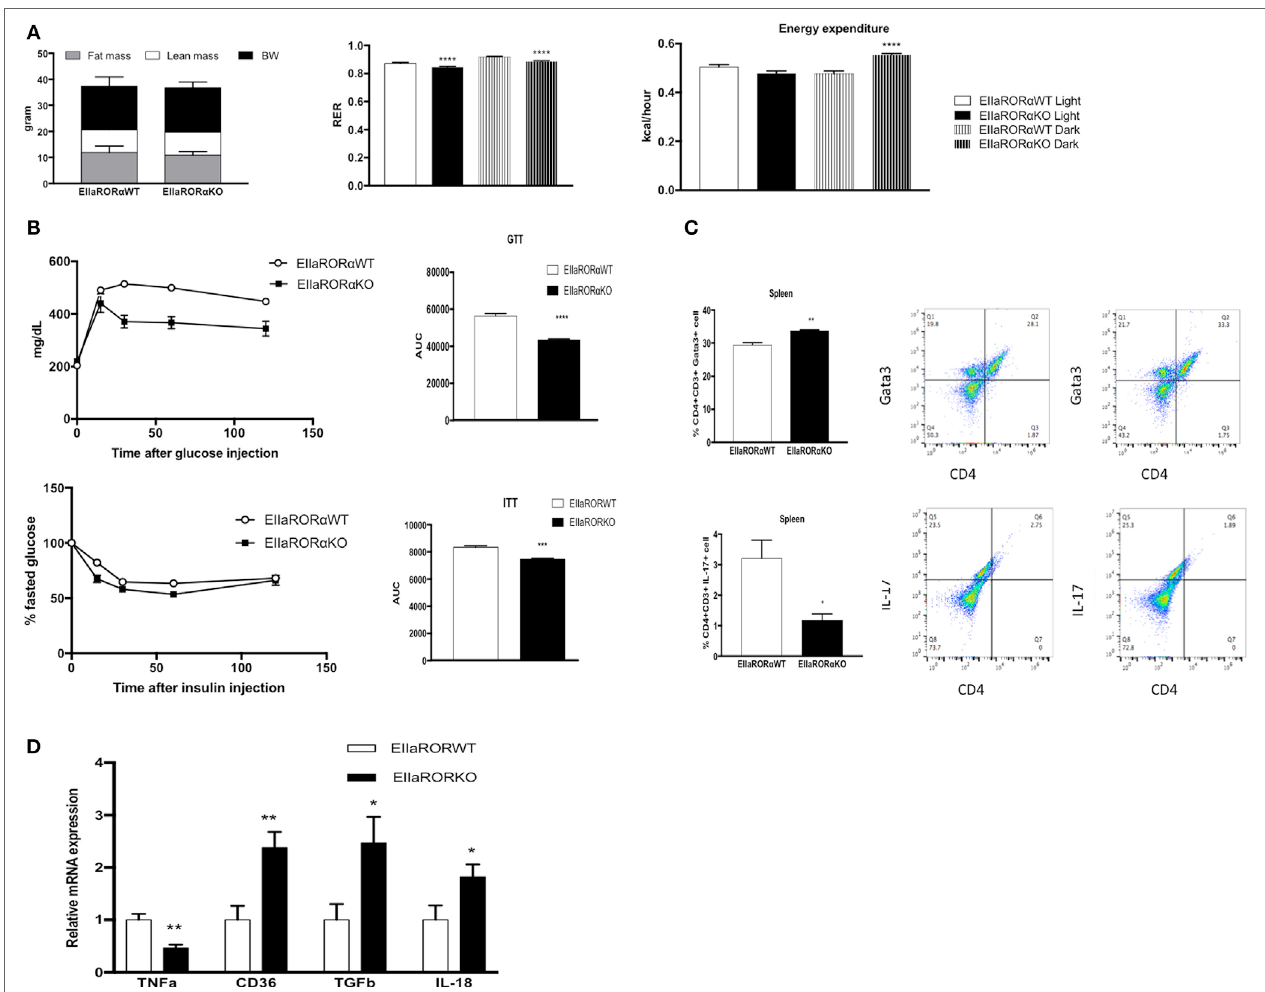
FigUre 5 | Aged-EIIAROR α KO display improved glucose homeostasis and a lower inflammation rate than EIIAROR α WT mice. (a) Body composition of single-housed 15-month-old males EIIAROR α WT ( n = 6) and EIIAROR α KO ( n = 7) littermates (left panel) fed with a normal chow diet. Respiration exchange ratio (middle panel) and heat production (right panel) of the same aged-EIIAROR α WT (white, n = 6) and EIIAROR α KO (black, n = 7) littermates during day (solid pattern) or night (shaded pattern) over a 5-day period and after 24 h acclimation (upper panel). (B) Glucose (upper panel) and insulin (lower panel) tolerance test from the same males aged-EIIAROR α WT (white triangle, n = 6) and EIIAROR α KO (black square, n = 7) fed with a normal chow diet done at 13-month old. Area under the curve is represented on each graph. (c) Splenocytes from 15-month-old males EIIAROR α WT (white bar, n = 6) and EIIAROR α KO (black bar, n = 7) littermates were analyzed by flow cytometry for T H 2 [CD3 + CD4 + Gata3 + (upper panel)], or T H 17 [CD3 + CD4 + IL-17 + (lower panel)]. (D) WAT gene expression from the same 15-month- old males EIIAROR α WT (white bar, n = 6) and EIIAROR α KO (black bar, n = 7) littermates (* p < 0.05, ** p < 0.01, *** p < 0.001, **** p <